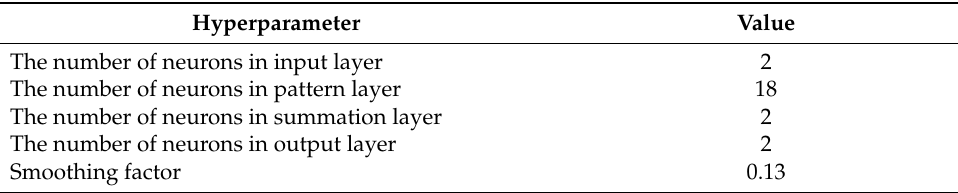
Table 2. The hyperparameters for best results with